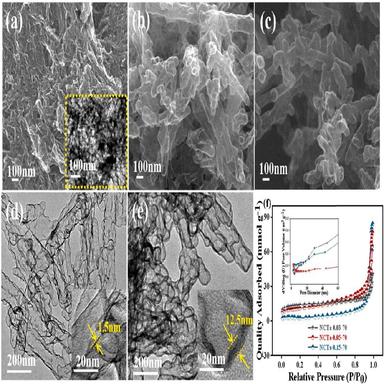
(a) SEM image and inset is the TEM image of NCTs-0.03–70, (b-c) SEM images of NCTs-0.03/− 0.05/− 0.15–70, (d, e) TEM images of NCTs-0.05/− 0.15–70 and inset are the corresponding enlarge figures, (f) N2 adsorption-desorption isotherms, and inset of the pore size distribution (PSD) of NCTs-0.03/− 0.05/− 0.15–70.